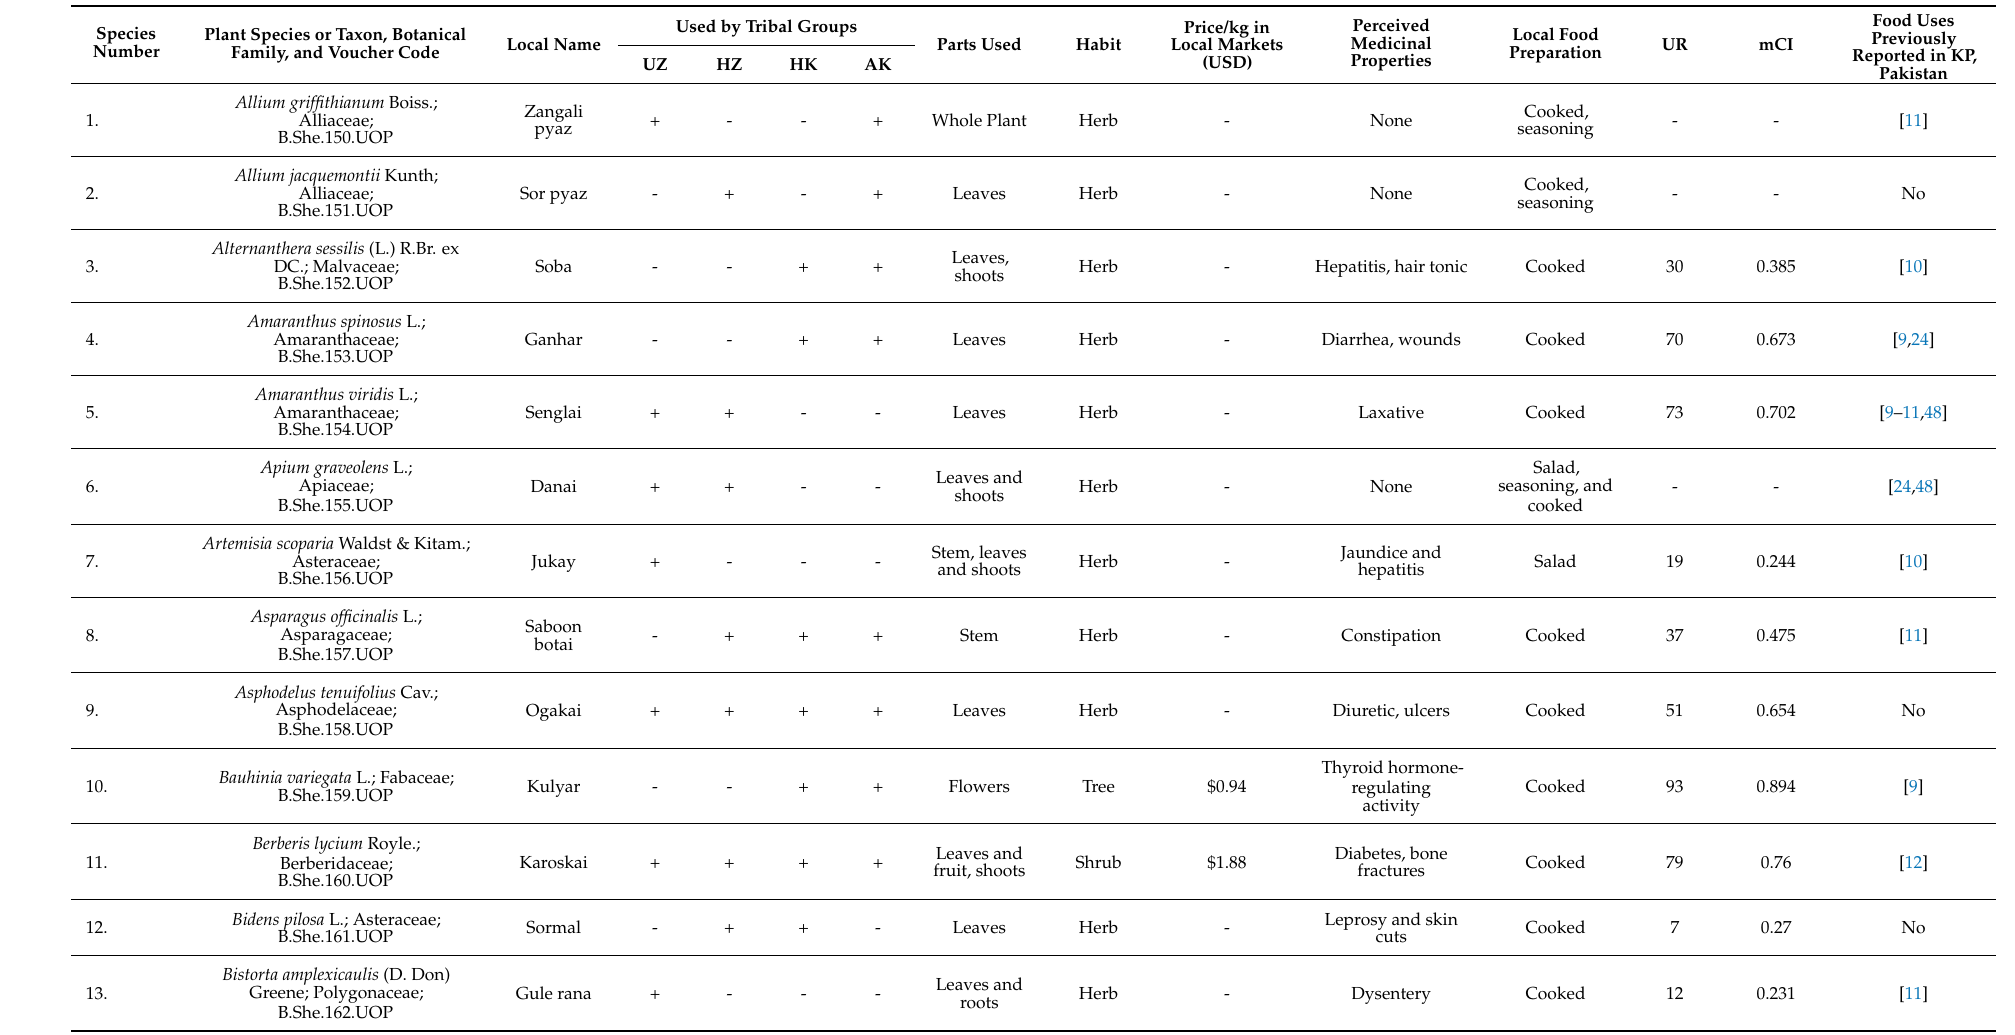
Table 3. Non-cultigens gathered and consumed in the Gadoon